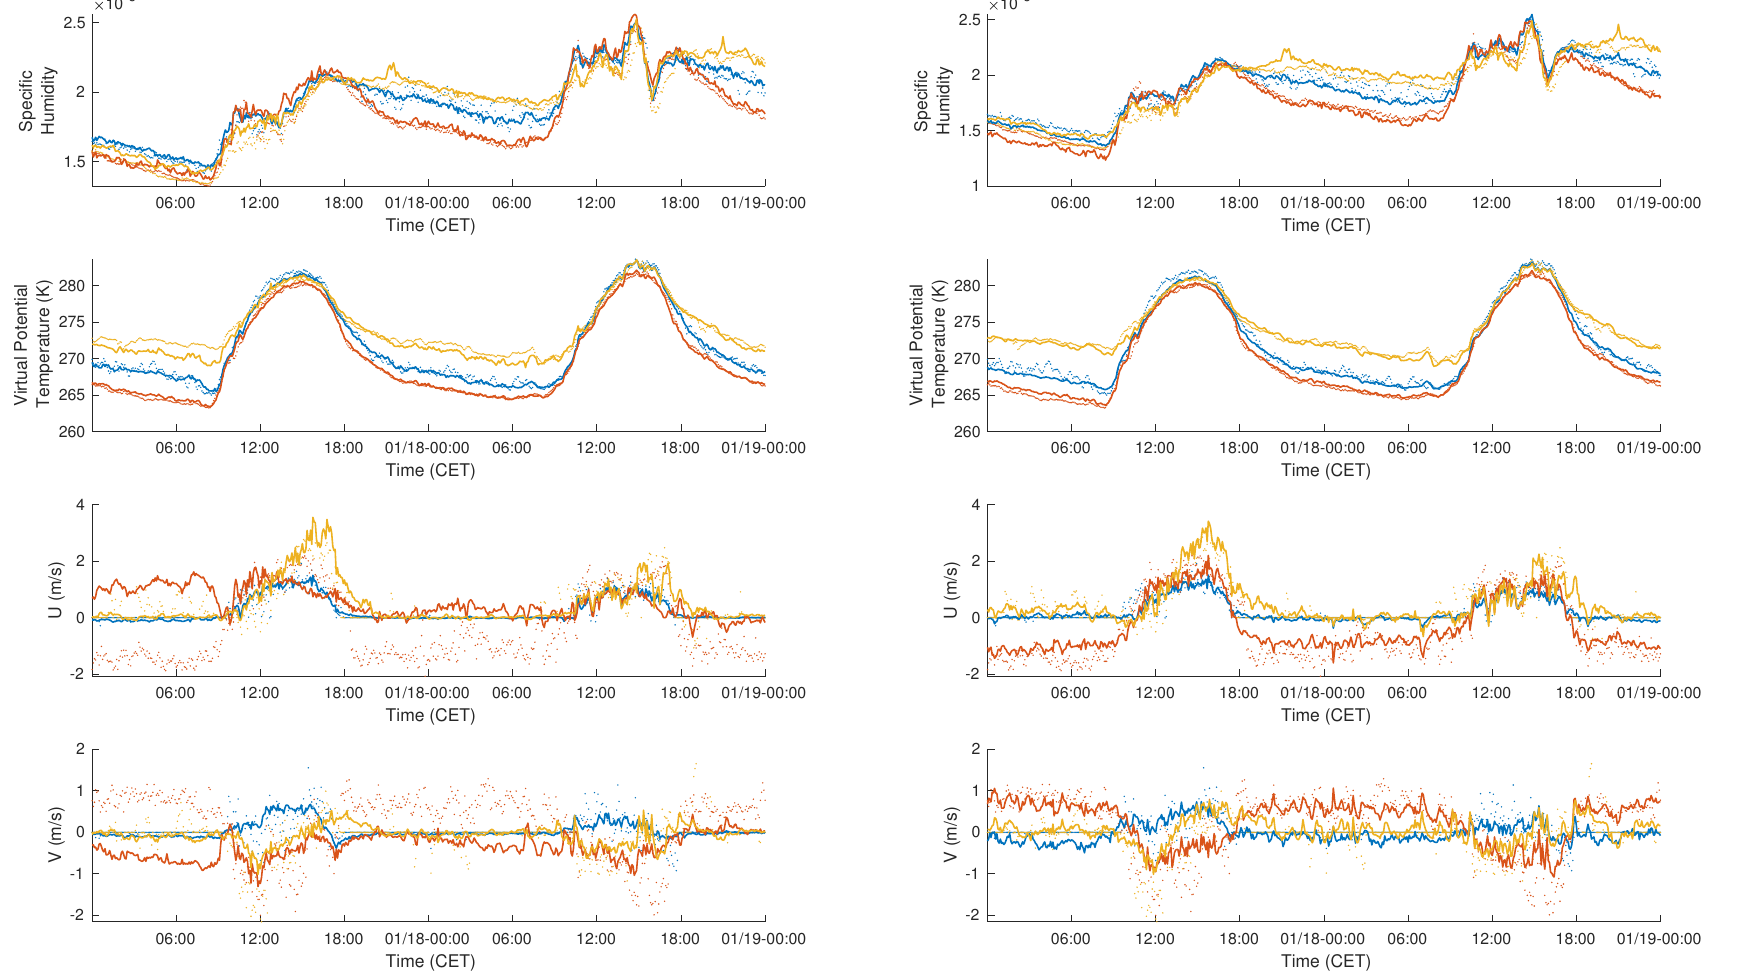
Figure 5. Time series for 17 January 2017 to 19 January 2017 in local standard time, representing a subset of the thermally-driven flow period. The ( left ) column of plots shows the ANN predictions compared to the data, and the ( right ) column of plots shows the MLR predictions compared to the data. The solid lines are predictions, while the dotted lines are measurements. Blue is LEMS A, red is LEMS E, and yellow is LEMS